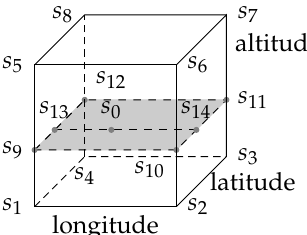
Figure 8. A representation to estimate dimension by dimension with linear interpolation for d = 3. s 1 , s 2 , . . . , s 8 are the observations, and s 0 lies on the grey plane. The value at the intermediate locations ( s ) and ( s ) are to be interpolated. 9 , s 10 , s 11 , s 12 13 , s 14